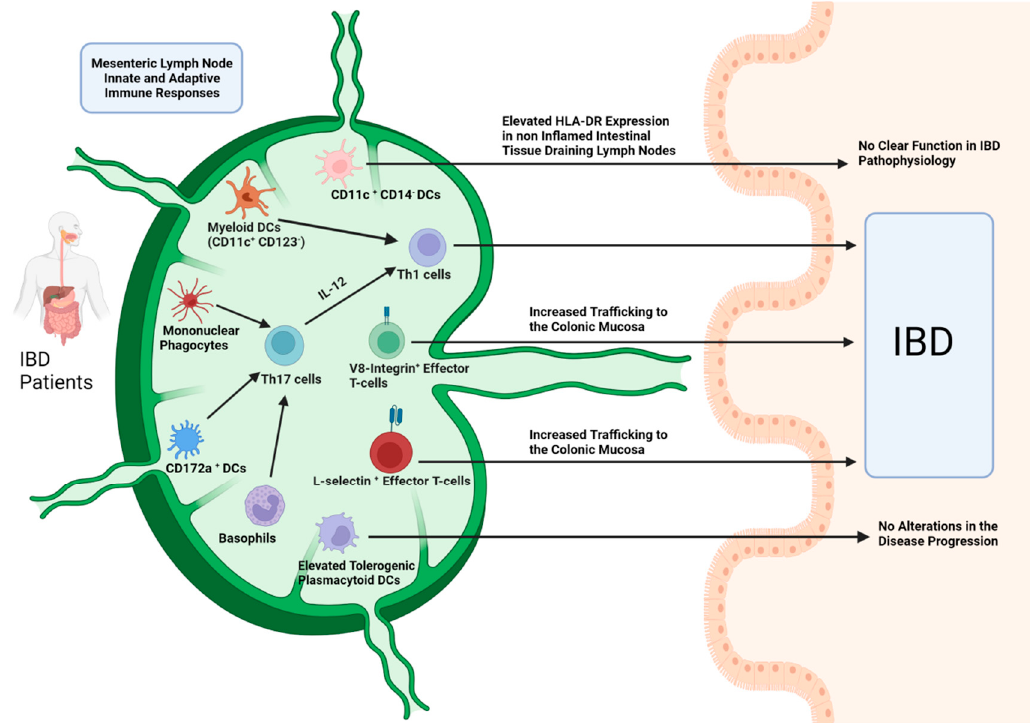
Figure 2. Adaptive and Innate Immune cell responses in MLNs of patients with IBD: Myeloid DC populations promote Th1 and Th17 responses linked with IBD initiation, whereas plasmacytoid DCs (pDCs) demonstrate a tolerogenic phenotype. However, these pDCs cannot alter the disease activity and progression. Basophils and mononuclear phagocytes promote Th17 responses. Th17 to Th1 polarization is a potential pathogenetic mechanism along with elevated effector T-cell trafficking to the colonic mucosa through lymphatic vessels. Reduced numbers of the tolerogenic CD103 + DCs in MLNs can further contribute to the disease pathogenesis. (Figure created with BioRen ‐ der.com ‐ accessed date: 20 ‐ 12 ‐ 2021).